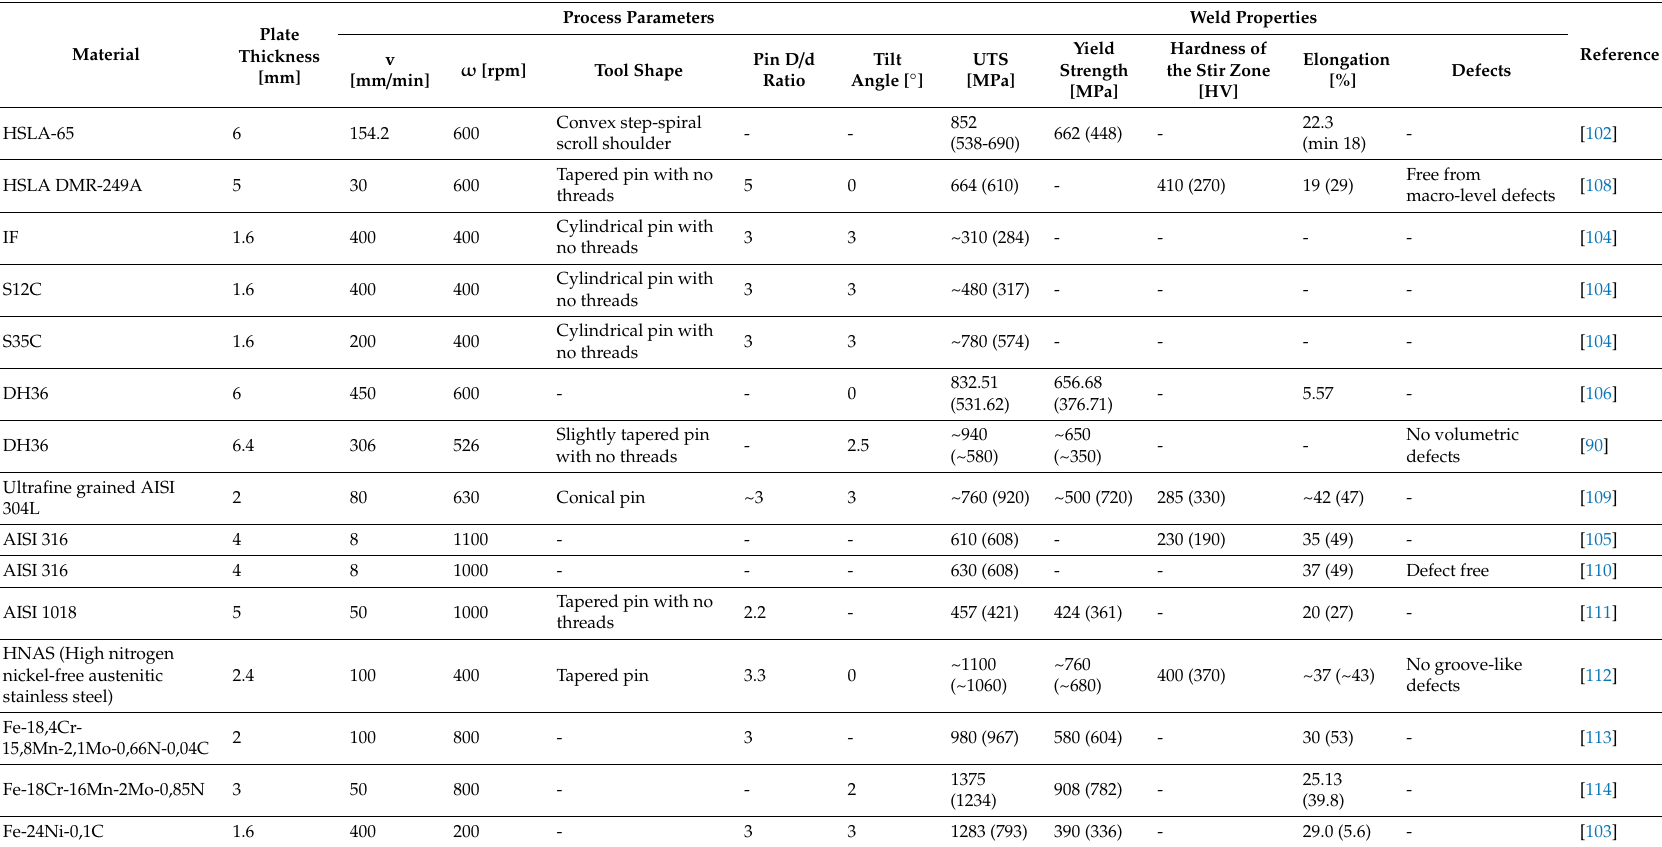
Table 3. FSW of steel and ferrous alloys—process parameters and mechanical properties of the